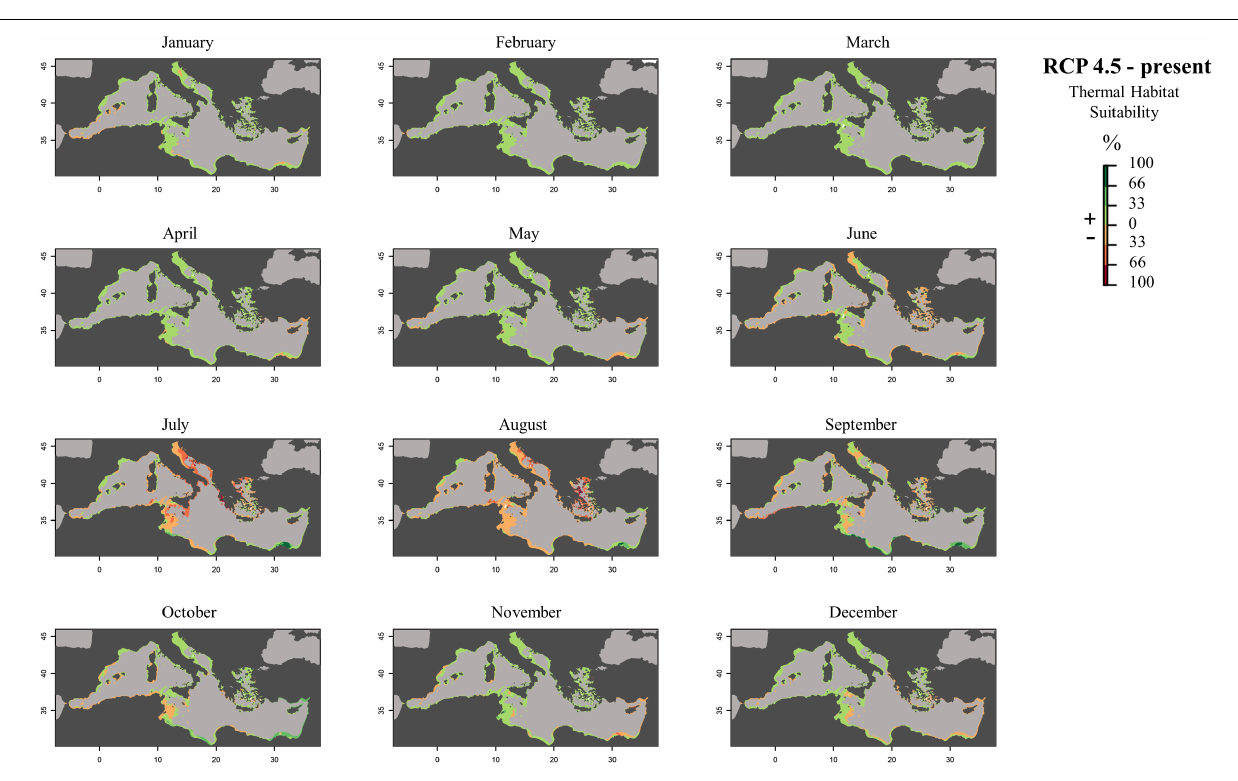
FIGURE 7 | Monthly prediction maps representing the subtraction between future (RCP 4.5) and present habitat suitability raster files: positive percentage values represent an increase in the suitability of the habitat in the future scenario, while negative percentage values represent a decrease in the occurrence probability of the species in that